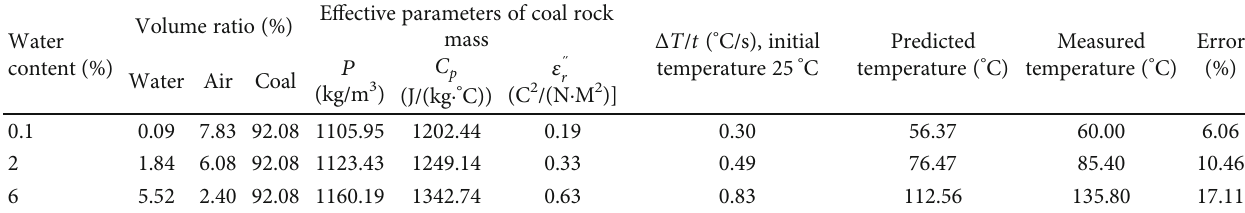
Table 4: Temperature rise rate of coal rock samples with di ff erent water contents under microwave irradiation.